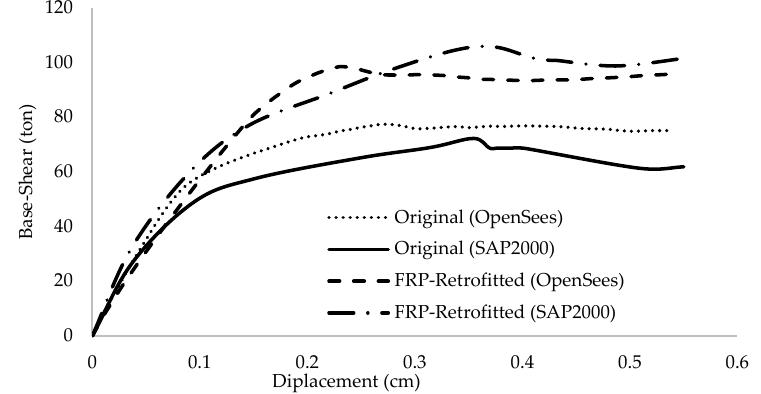
Figure 7. The results of the pushover analysis for original and wed ‐ bonded CFRP frames.